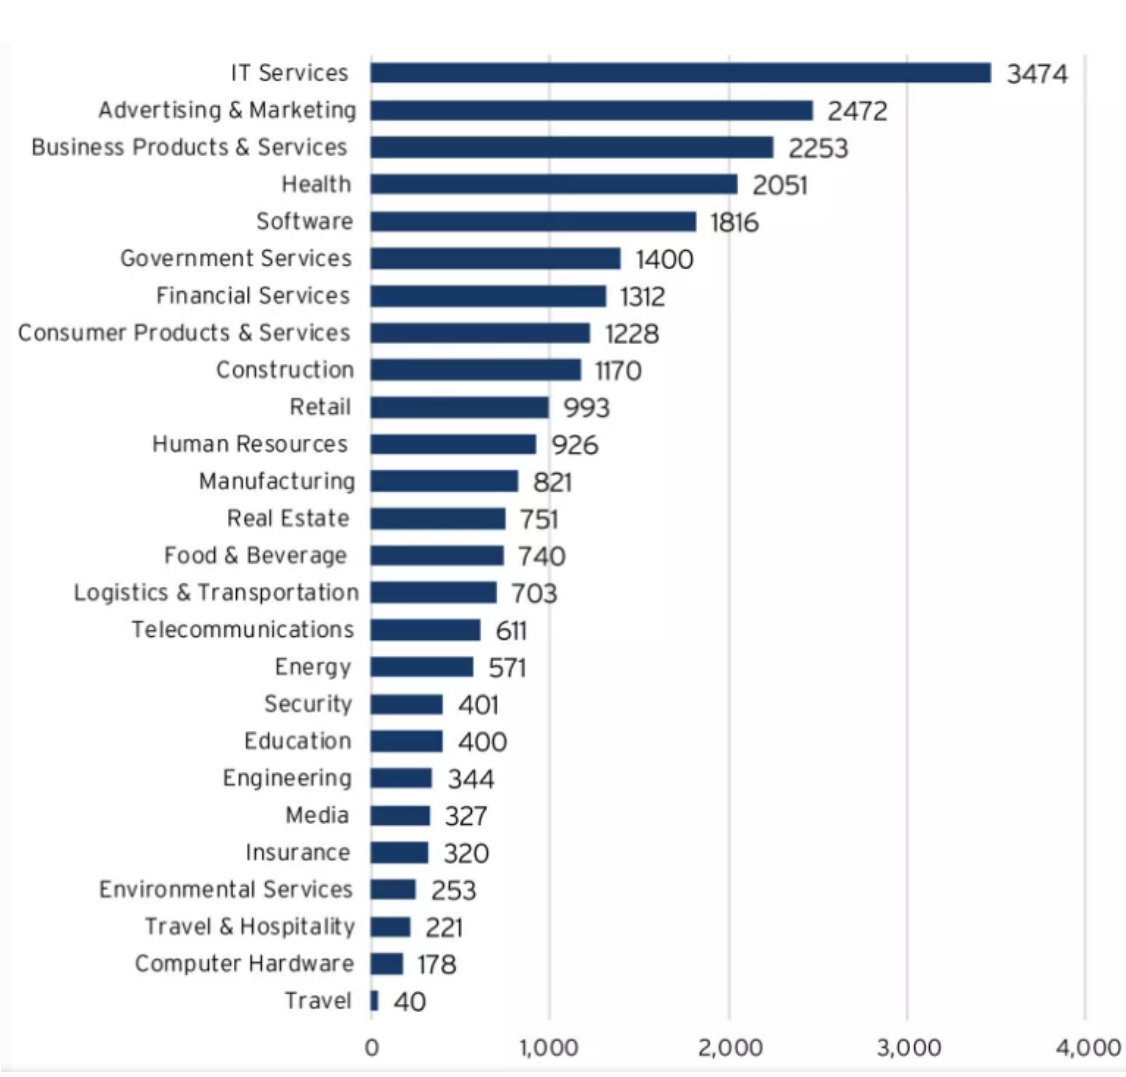
Fig. 8 . High growth company industries 51 in the US